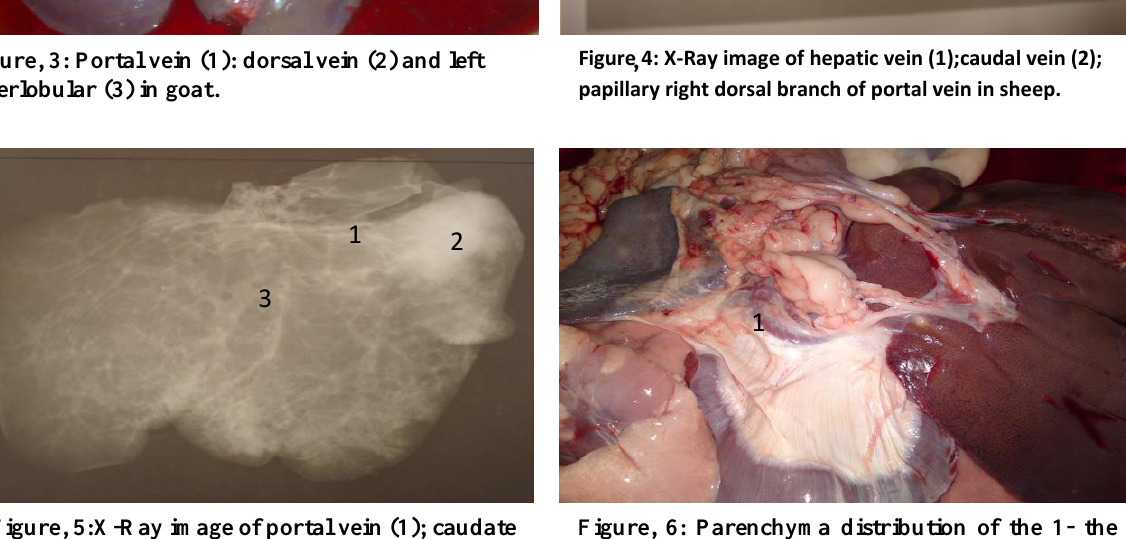
Figure, 6: Parenchyma distribution of the 1- the diaphragmatic branch of portal vein in goat.